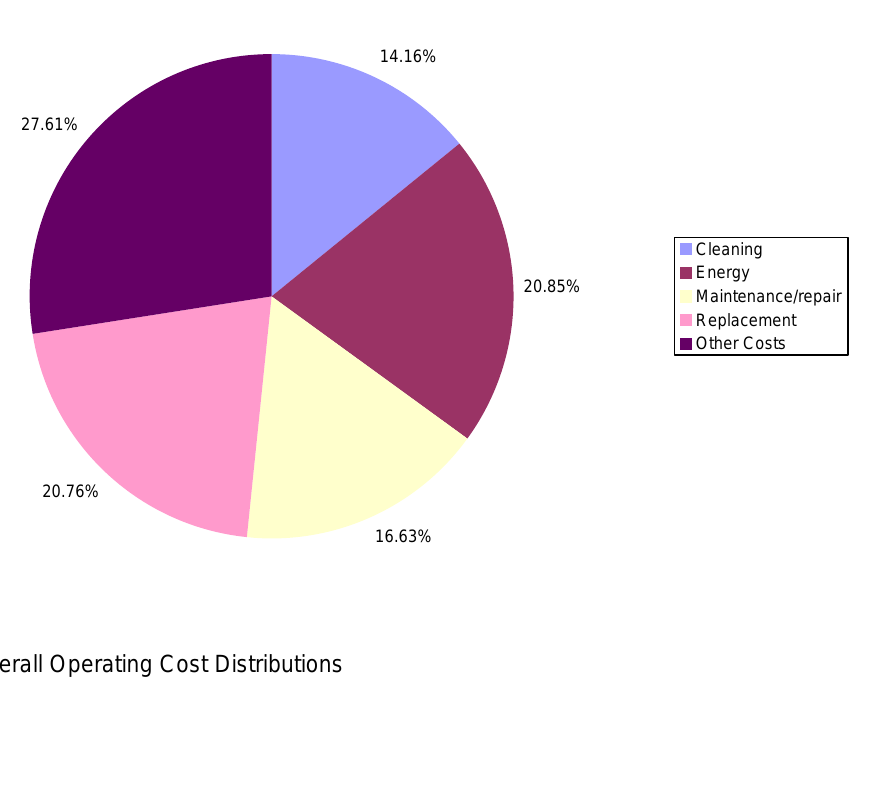
Figure 5: Overall Operating Cost